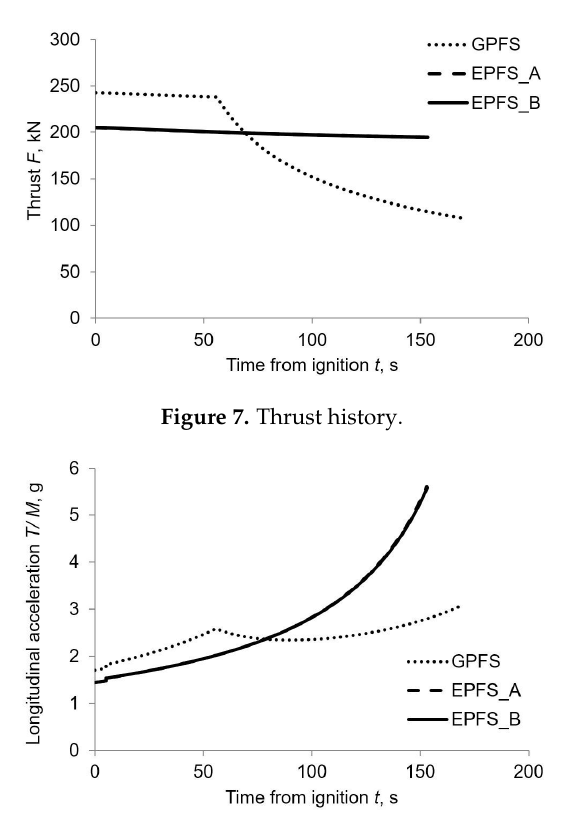
Figure 8. Longitudinal acceleration